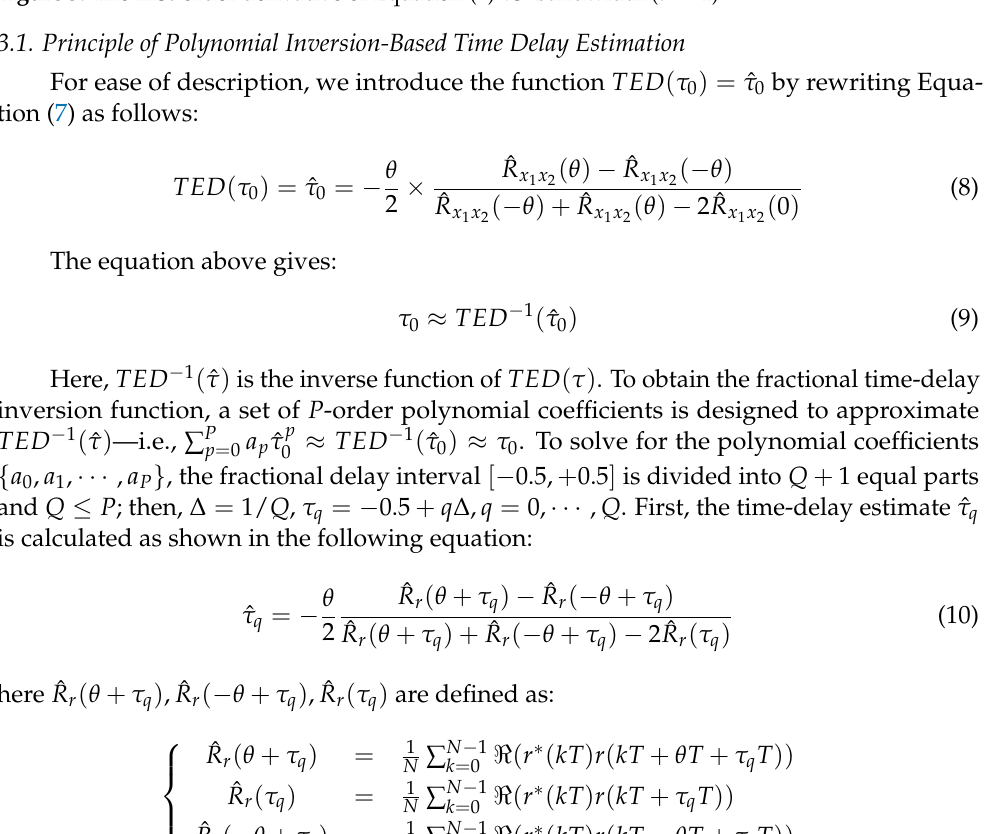
Figure 3. The first-order derivative of Equation (7) vs. bandwidth ( θ =